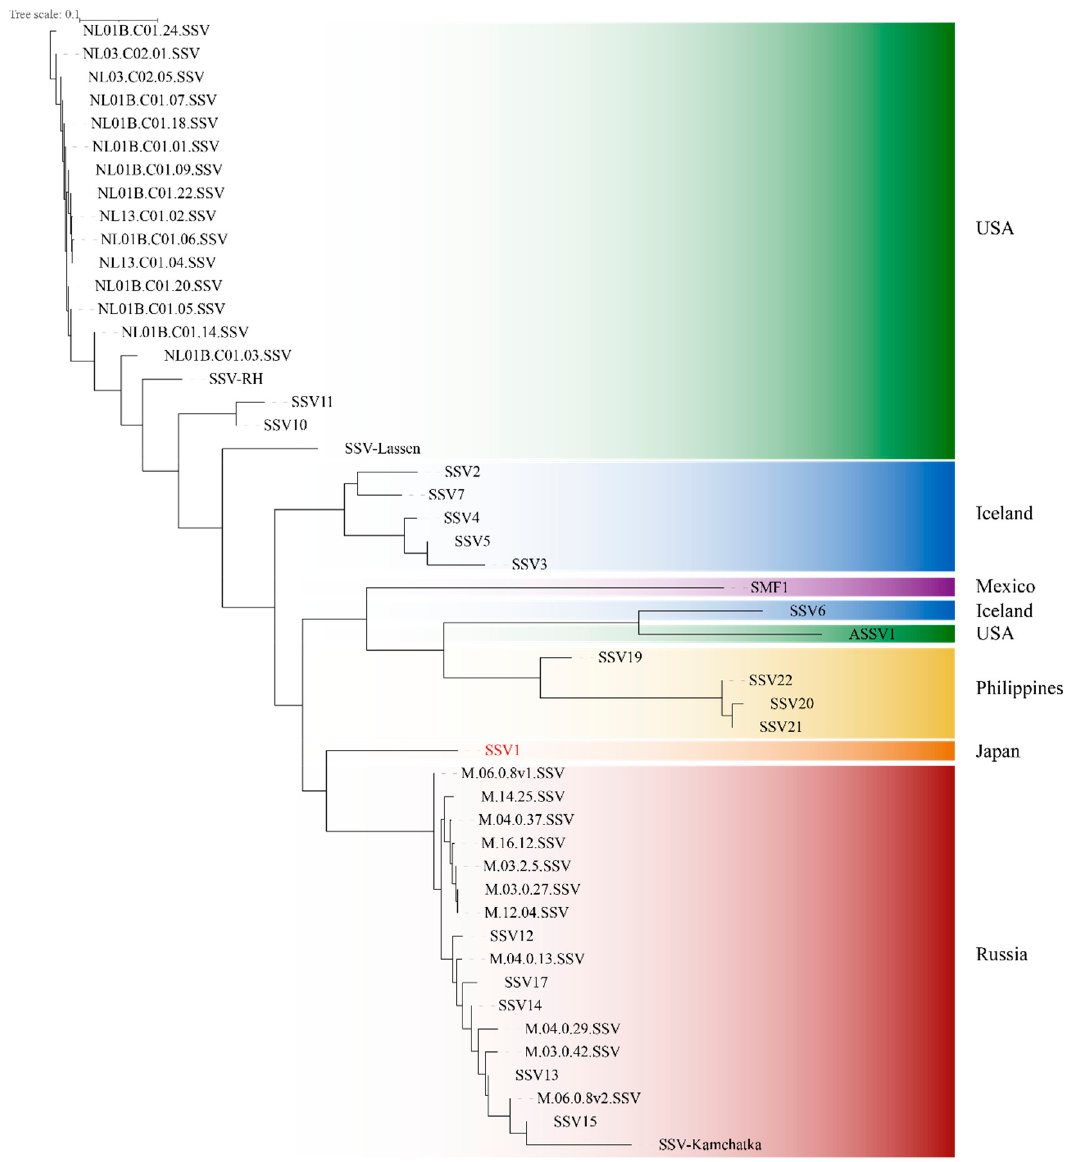
Figure 3. Phylogeny of the Fuselloviridae . The phylogeny of the 49 fusellovirus sequences was obtained with OrthoFinder, which uses the predicted orthogroups to infer a tree using STAG and roots the tree with STRIDE [31,50,51]. Viruses cluster according to their geographic location, as shown by the color code.